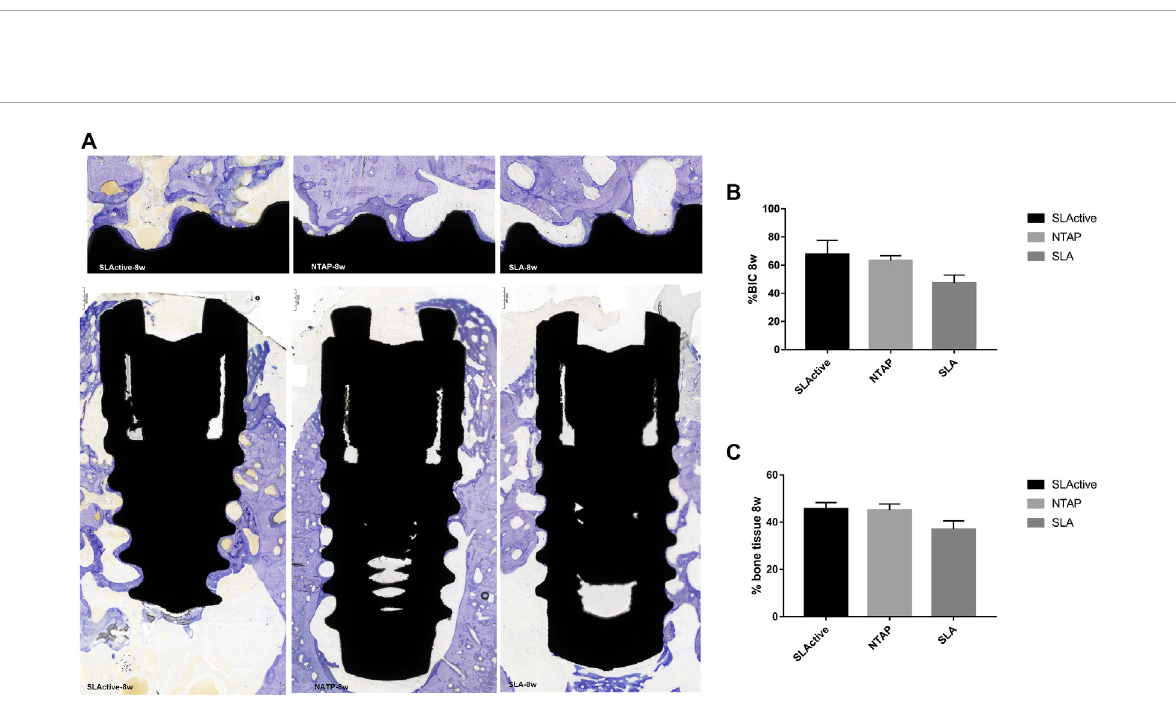
FIGURE 7 Histological section and analysis after 8 weeks of implantation ( n = 3). (A) New bone formation was assessed by toluidine blue staining in the SLActive, NTAP, and SLA groups. Magni fi cation: upper ×10; lower ×2 and scalebar = 500 μ m. (B) Percentage of histological BIC. (C) Percentage of bone tissue in wound chamber. Values represent the means of data obtained from three different experiments with standard deviations. * = p < 0.05 of the Friedman test using IBM SPSS 26 (the error bars indicate standard